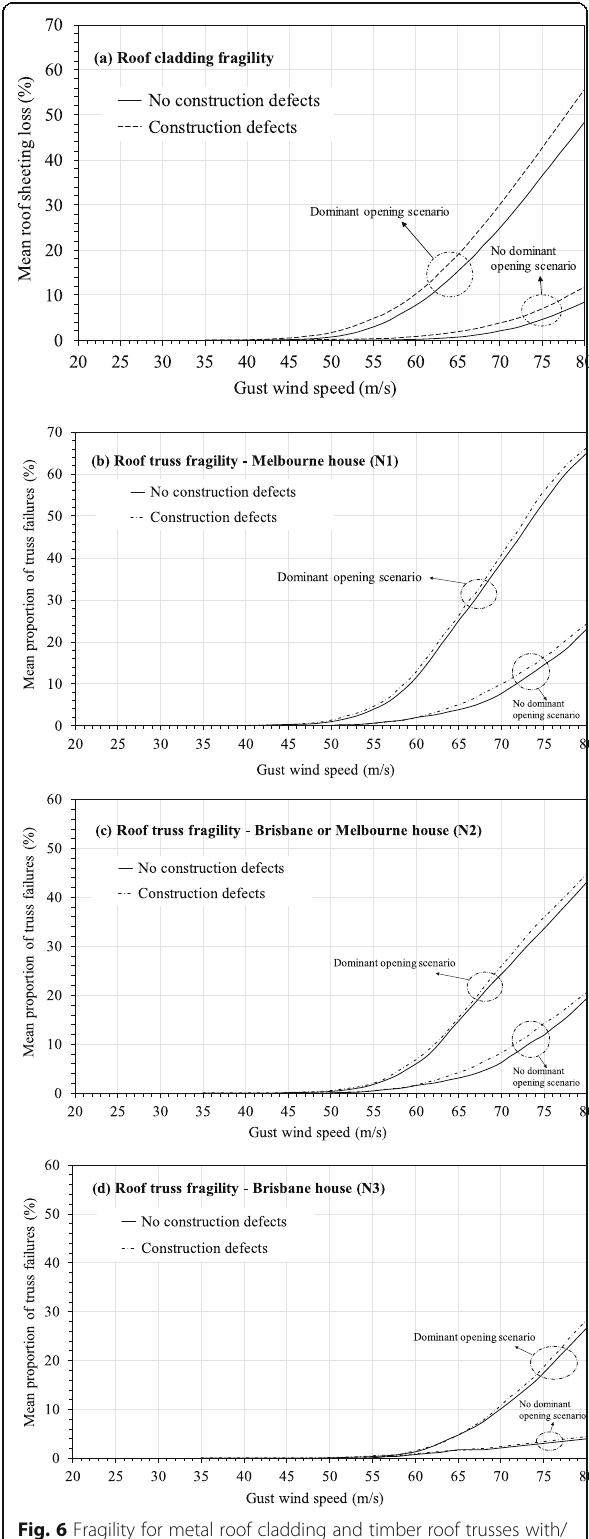
Fig. 6 Fragility for metal roof cladding and timber roof trusses with/ without construction defects